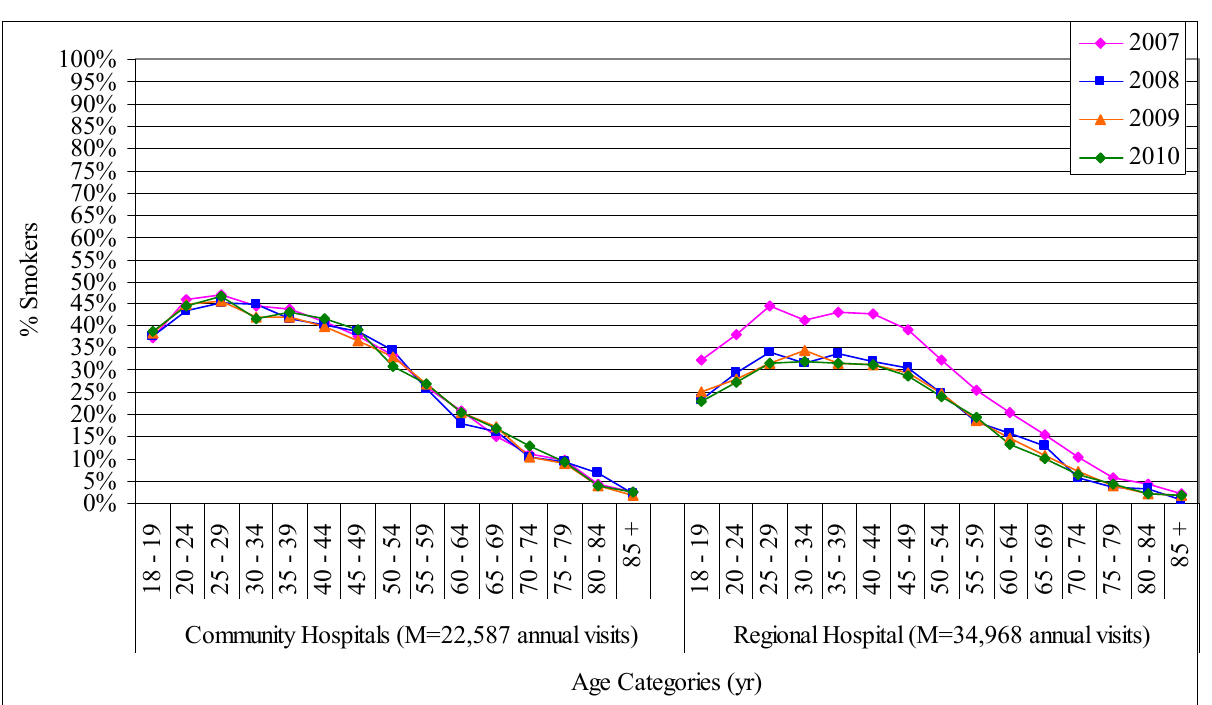
Figure 1. Tobacco Use Prevalence for Community and Regional Hospitals by Age and Year (2007 – 2010).